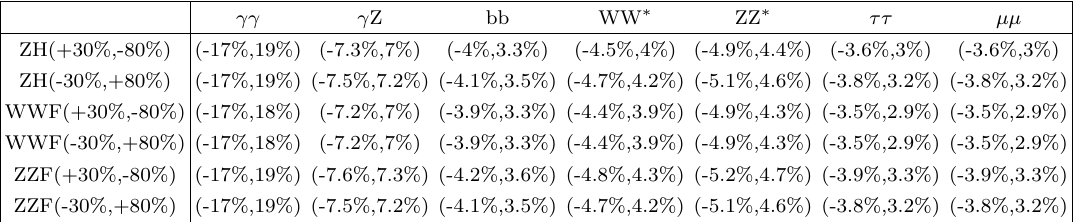
Table 11 . Possible deviations in signal strengths (in percent) caused by top-quark operators, in Higgs production (WWF for WW fusion and ZZF for ZZ fusion) and decay channels, at an e + e (cid:0) collider at 250 GeV centre-of-mass energy. Only the coe(cid:14)cient of O t’ is allowed to vary within the current constraints, described in table